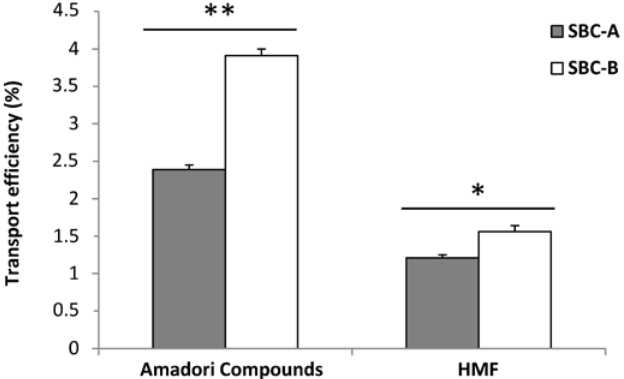
Figure 1. Transport efficiency (%) of Amadori Compounds (measured as furosine, the artificial amino acid formed during acid hydrolysis of this product) and HMF after 2 h exposure to soluble fraction of bread crust at two different concentrations. Values are mean ± standard error (SE) ( n = 3). The asterisk on the bars of a compound indicates significant differences between samples (* = p < 0.05; ** = p < 0.001). SBC-A: soluble bread crust fraction dilution 1:3 ( v / v ); SBC-B: soluble bread crust fraction dilution 1:9 ( v / v ). Table 2. Amadori compounds (as furosine 1 ) and HMF transport in Caco-2 cell monolayer after 2 h of incubation with digested bread crust or its fractions.